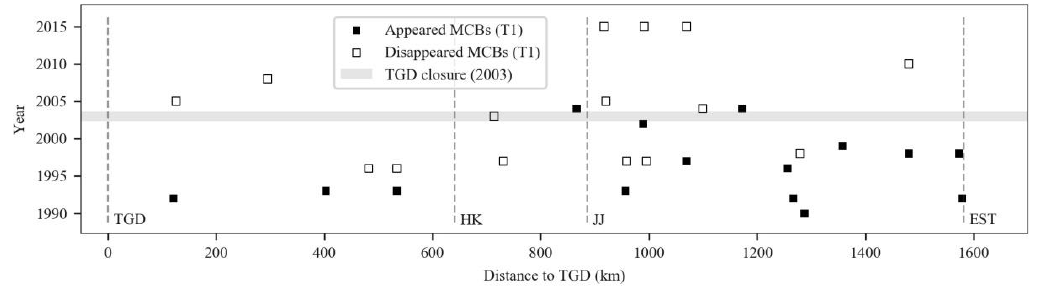
Figure 8. Longitudinal-temporal distribution of number change events.